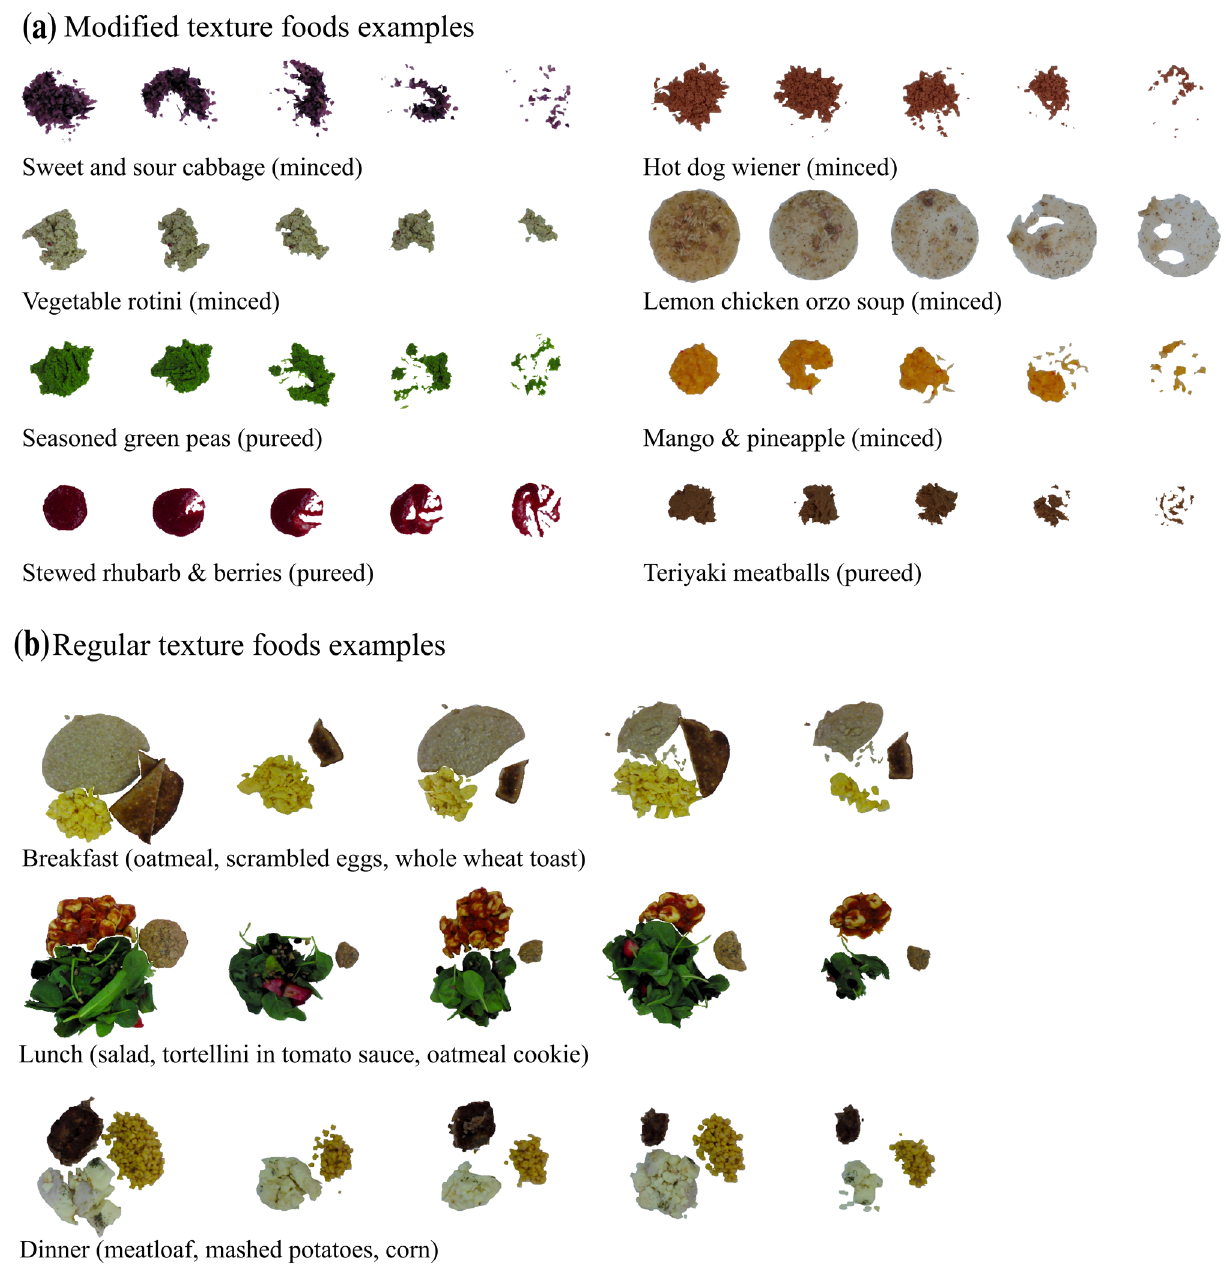
Figure 2. Example images from our custom LTC simulated intake dataset consisting of colour (RGB), depth and mass amounts (colour examples shown here) in ( a ) the modified texture foods dataset, and ( b ) the regular texture foods dataset. The modified texture foods dataset comprises 5 reference portion images whereas images of the regular texture dataset represent three meals at every iteration of 25% simulated intake (a subset shown